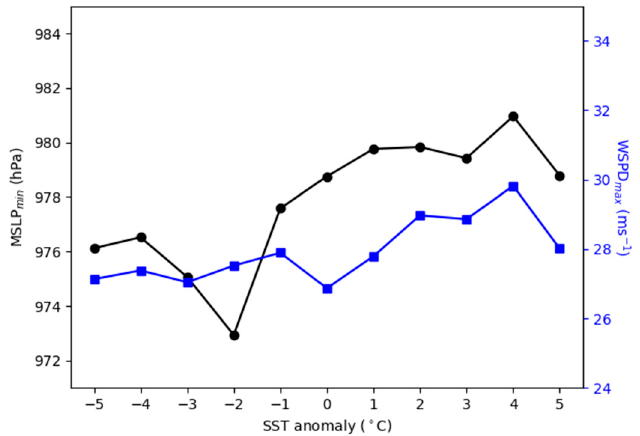
Figure 29. Minimum MSLP (black line) at the time of the peak of the storm (lowest MSLP) and maximum 10 m wind speed (blue line) three hours before the peak for all SST anomalies.